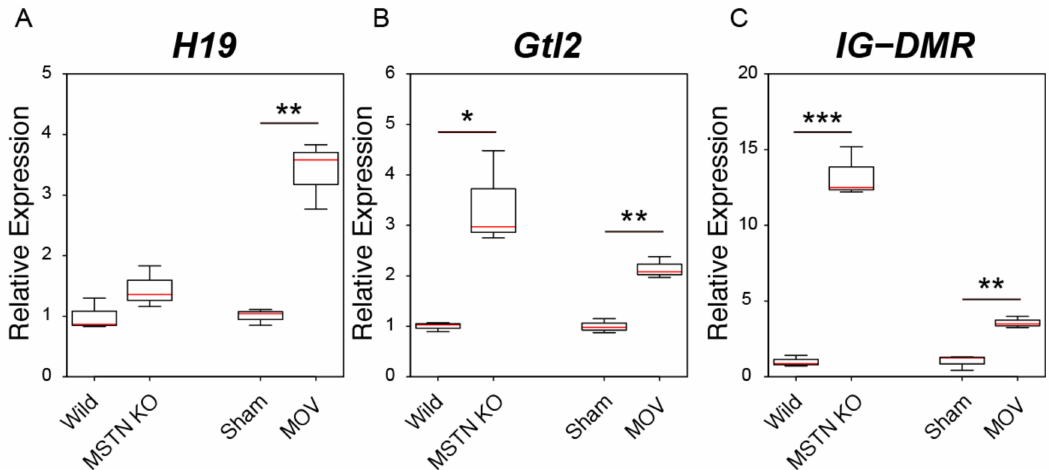
Figure 5. Changes in the expression levels of genomic imprinting-related lncRNAs in skeletal muscle hypertrophy conditions. ( A – C ) Box-and-whisker plots showing the results of quantitative RT-PCR (qRT-PCR) for H19 ( A ), Gtl2 ( B ), and IG-DMR ( C ) expression in two muscle hypertrophy conditions. Wild; TA muscles of control C57BL / 6J mice. MSTN KO; TA muscles of C57BL / 6J-background myostatin knockout mice. Sham; plantaris muscles of sham-operated C57BL / 6J mice. MOV; plantaris muscles of mechanical overload (MOV)-operated C57BL / 6J mice. qRT-PCR data were normalized to Rpl26 expression and shown as relative expression. n = 3 per group. * p < 0.05. ** p < 0.01. *** p < 0.001.